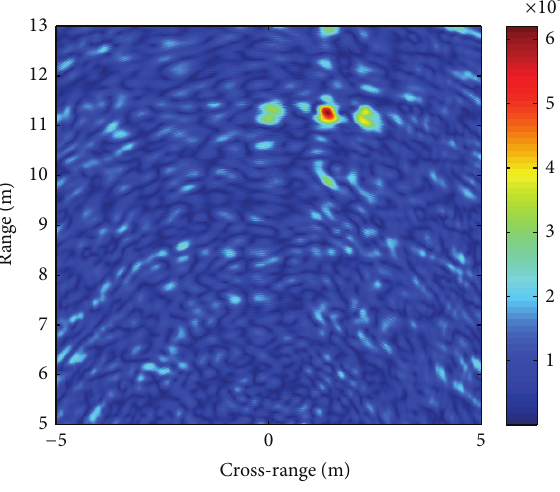
Figure 19: The processing result by the method proposed in this paper.